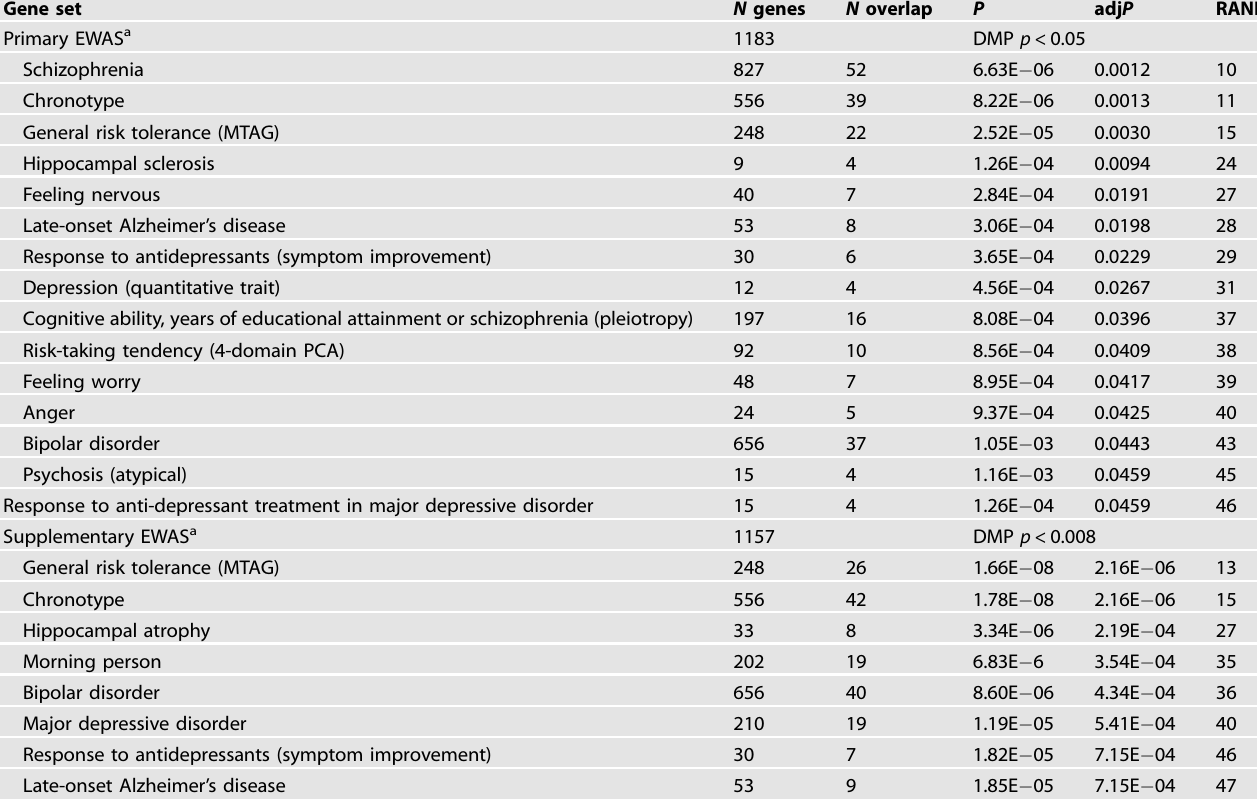
Table 1. Summary of neurobehavioral phenotypes within the top 50 ranked enrichments from FUMA GWAS catalog . Gene set